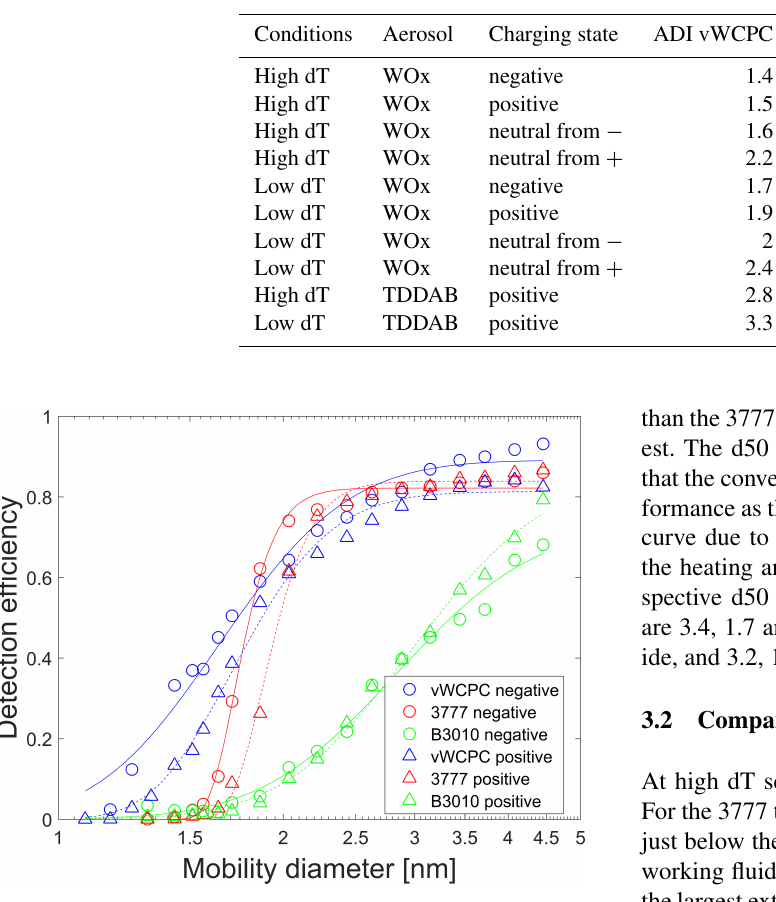
Figure 5. Detection efficiency of the CPCs as a function of size for negatively and positively charged tungsten oxide particles at low dT